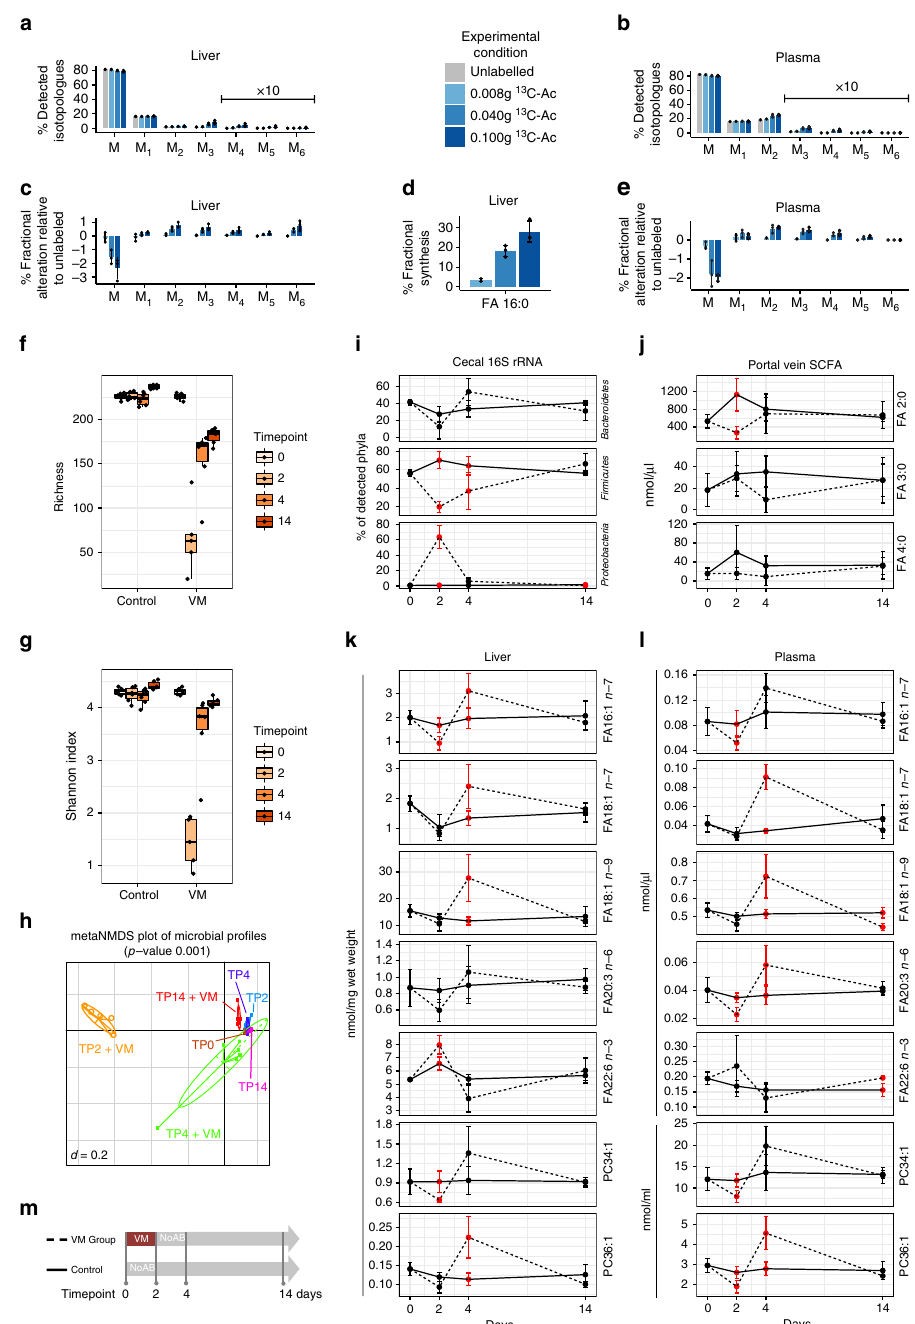
Fig. 5 Fiber-derived FA 2:0 is precursor for hepatic synthesis of fatty acids and glycerophospholipids. SPF mice were supplemented with 13 C-FA 2:0 via oral gavage with the indicated amount ( n = 3/group), samples were taken 4 h after gavage. a Isotopologue distribution of FA 16:0 in liver and b plasma. c Fractional alterations (%) of M 0 , M 1 – M 6 isotopologues relative to unlabeled control in liver and e plasma. d Fraction of de novo synthesized FA 16:0 in liver. SPF mice were treated for 2 days with VM (TP2), additional 2 (TP4) or 10 days (TP14) without antibiotics ( n = 6/TP); control SPF mice did not receive antibiotics ( n = 6/TP). f Alpha-diversity analysis shown as richness counts and g Shannon effective counts. h Multidimensional scaling showing differences in the phylogenetic makeup of microbiota between samples ( β -diversity) based on general UniFrac distances. i Composition of major phylas determined in cecum content. j Portal vein SCFA levels. k Levels of selected MUFA, PUFA and MUPC in liver and l plasma. AB: antibiotics, Ac: acetate, VM: vancomycin in combination with metronidazole. Red dots and error bars in i – l indicate a signi fi cant difference ( p < 0.05) between the control and VM group. m Experimental setup for the antibiotics experiment. In boxplots the thick lines represent the medians, the upper and lower lines of the boxes show the 25% and 75% quartiles and the whiskers are 1.5 times the interquartile range of the data. In barplots the error bars show the standard deviations. The dot plots in i – l show the mean and the standard deviation per group and